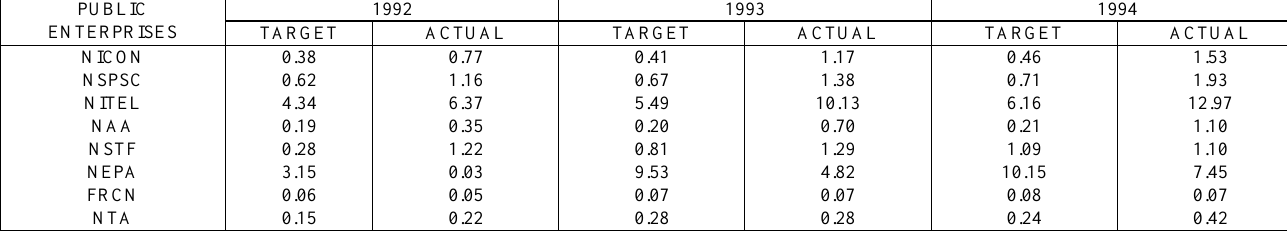
TABLE 8: TARIFF TRENDS (PRICES) 1985 – 1995 PUBLIC ENTERPRISES